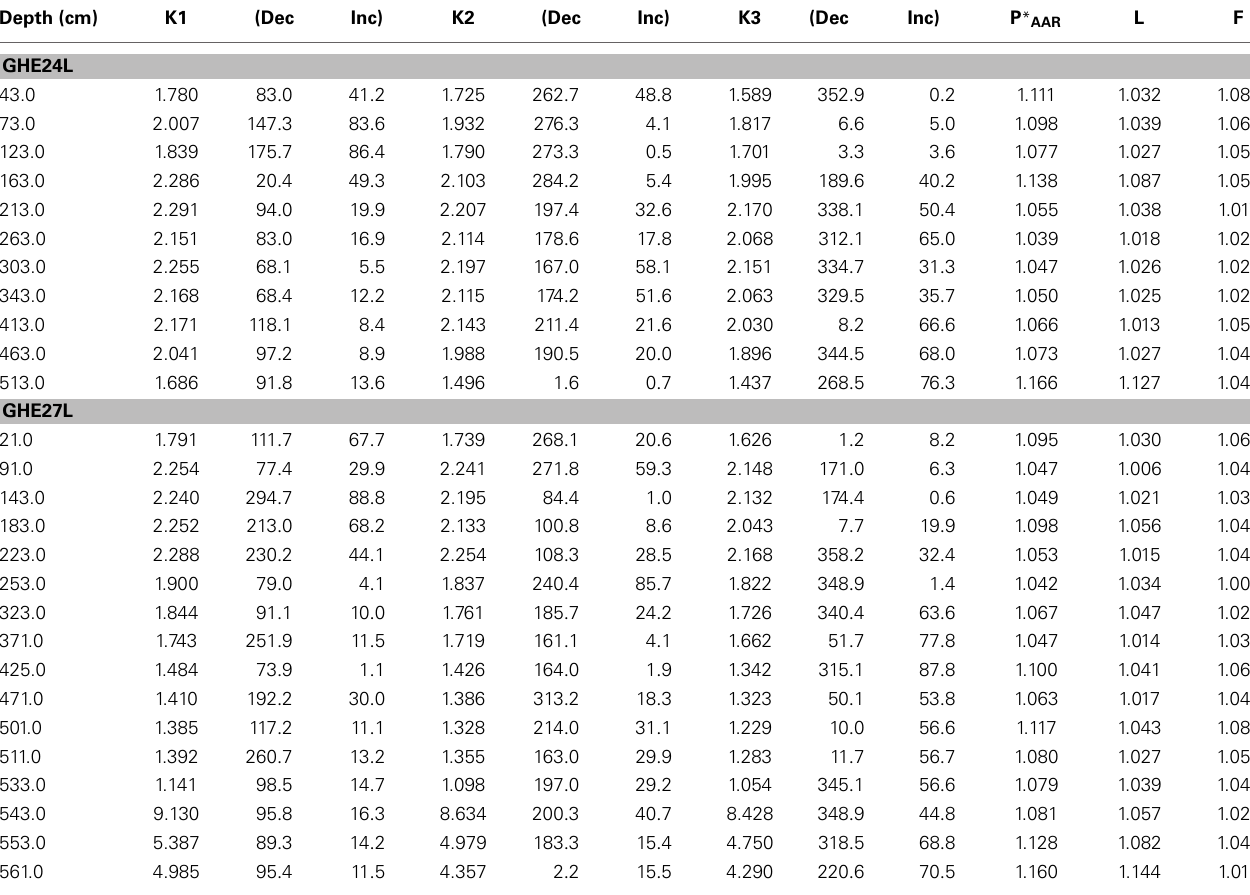
Table 1 | Anisotropy of anhysteretic remanence (AAR) data of selected samples from Cores GHE24L and GHE27L. Depth